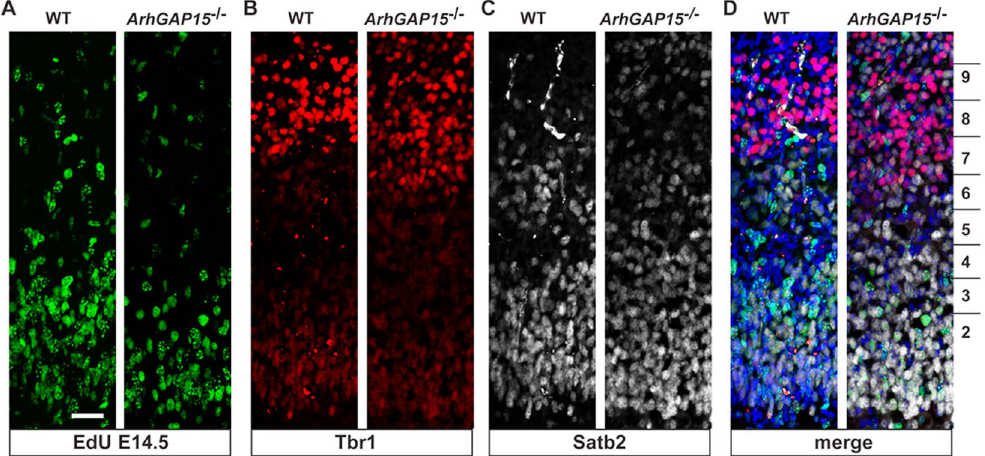
Figure 2. Genesis and organization of cortical pyramidal neurons in ArhGAP15 − / − mice. ( A ) Representative micrographs of EdU tracing of cortical neurons in WT (left) and ArhGAP15 − / − (right) cortices, examined at birth. Embryos were injected with EdU at the age E14.5. No difference in the number and position of EdU + neurons is detected. ( B – D ) Representative micrographs of immunostaining of WT and ArhGAP15 − / − cortices, at birth, for Tbr1 ( B ) and for Satb2 ( C ). The merged image (DAPI, EdU + , Tbr2 + , Satb2 + ) is shown in panel D. The subdivision in 10 BINs is reported in panel D. No differences in the number and position of the stained neurons were detected. Scale bar in A = 20 μ